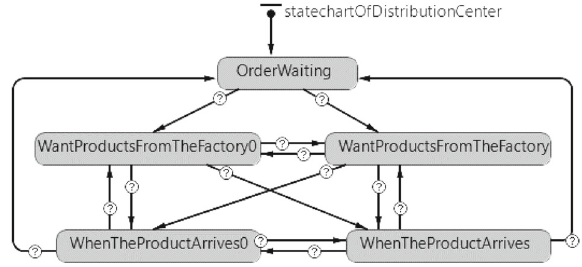
Fig. 5 Statechart of distribution center agent